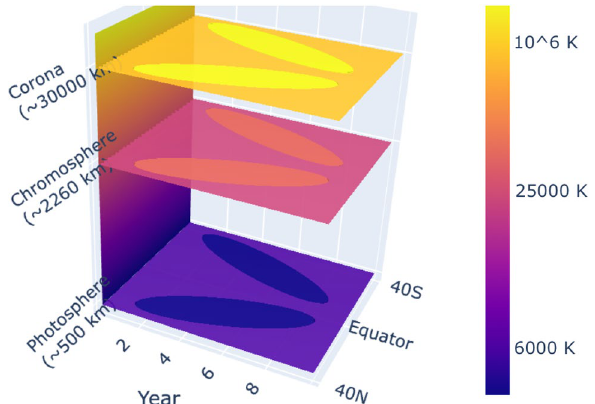
Figure 1. Illustration of the 3-dimensional solar butterfly body throughout the solar atmosphere from the photosphere to the corona. The x -axis roughly indicates time-unit years in the 11-year solar cycle, the y -axis indicates latitudes within 40 ◦ (N: the northern hemisphere, and S: the southern), and the z -axis indicates height from above the bottom of the